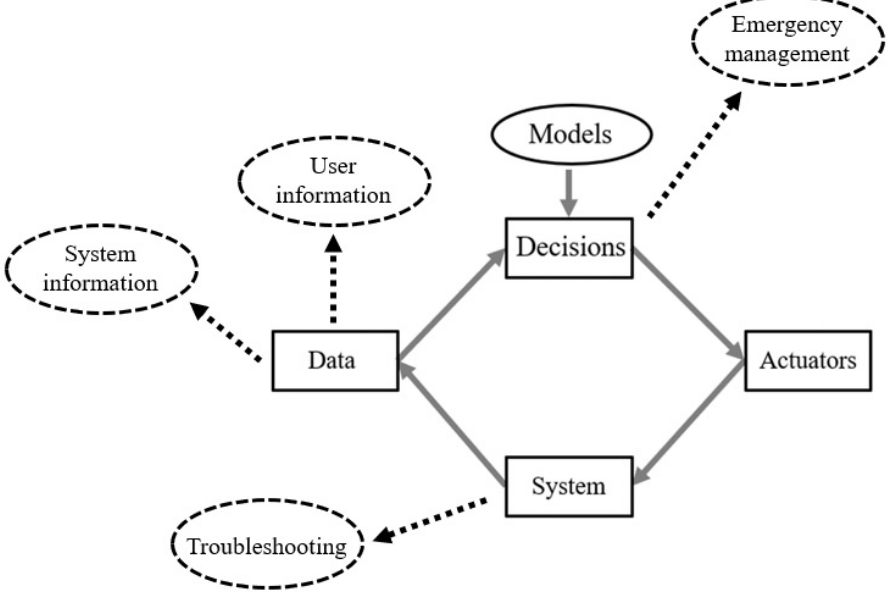
Figure 2. Systems control and information interfaces.